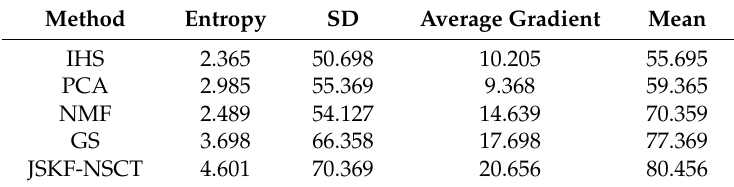
Table 6. Comparison of evaluation for five fusion methods for experiment B.